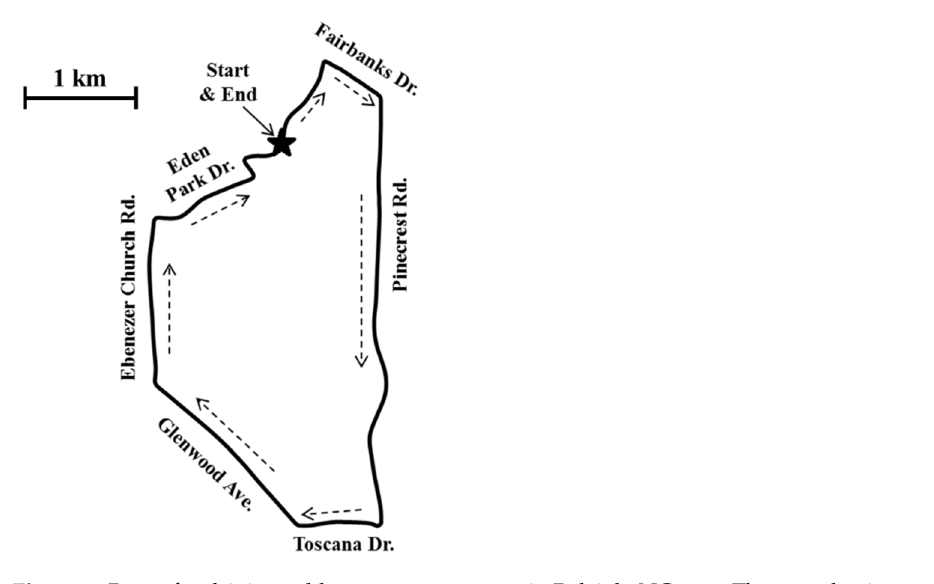
Figure 3. Route for driving cold start measurements in Raleigh, NC area. The route begins on Clarks Branch Drive and returns to the same location after a clockwise circuit.